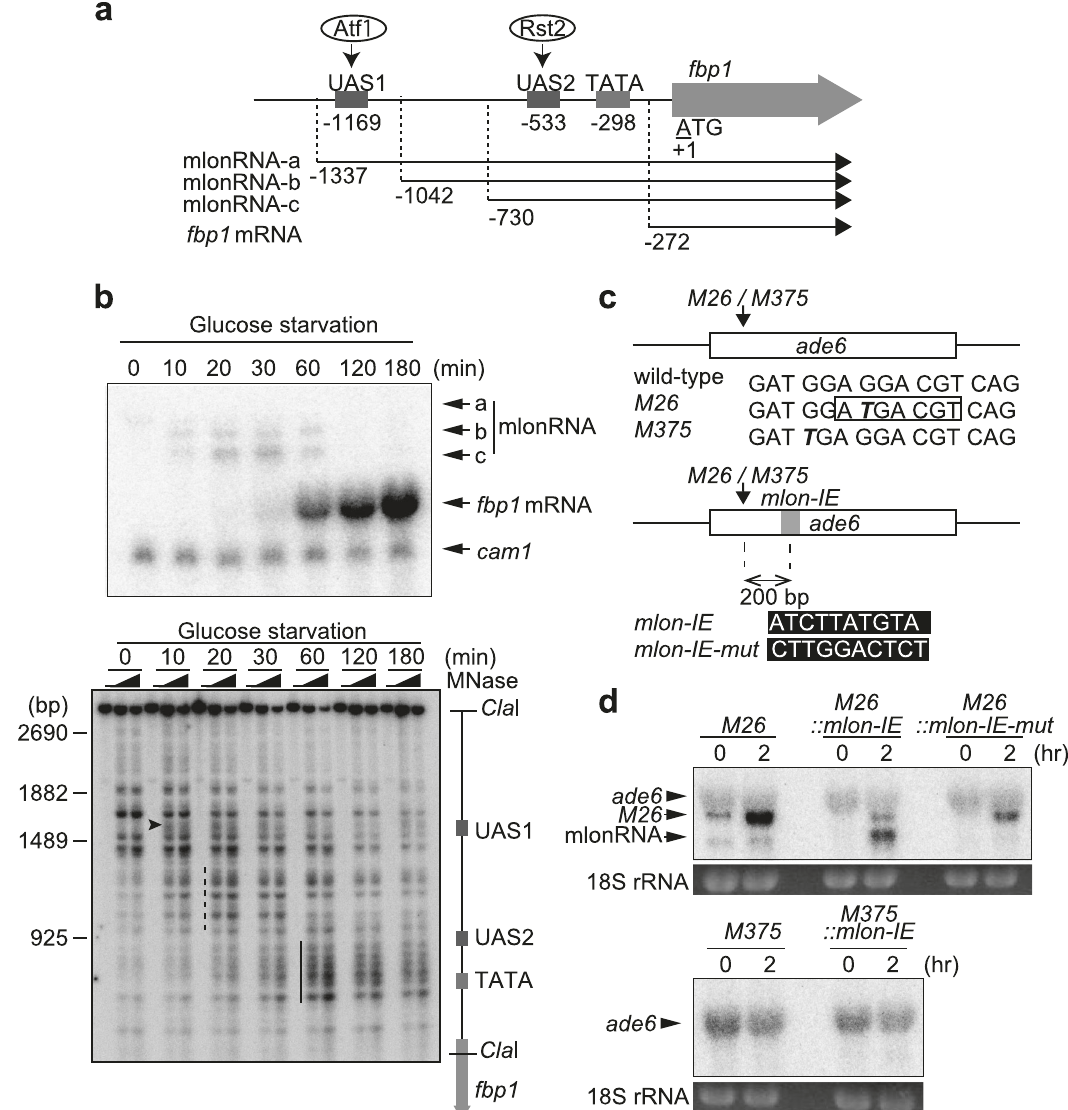
Fig. 1 mlon-IE works at other loci and conditions in addition to its role in the fbp1 upstream region. a Schematic representation of the fbp1 upstream region containing upstream activating sequence 1 and 2 (UAS1 and UAS2), the binding sites for Atf1 and Rst2, respectively. The numbers indicate the transcription start site of the fbp1 transcripts and the distances of UAS1, UAS2 and the TATA box from the fi rst ATG of fbp1 open reading frame (ORF). b Representative images of northern blot showing stepwise expression of mlonRNAs and fbp1 mRNA and blot of the chromatin analysis showing stepwise chromatin remodeling during glucose starvation. Wild-type haploid cells were grown to 2.0 × 10 7 cells/ml in YER medium, then transferred to YED medium. Cells were harvested at the indicated times. cam1 transcript was used as an internal control. c M26 and M375 mutations in ade6 (bold italic) and inserted mlon-IE sequences are shown. d ade6 transcription in indicated cells. Diploid cells were cultured to induce meiosis, as described in the Methods section. 18S rRNA stained by ethidium bromide is shown as the loading (Supplementary Fig. 2a) 32 . M26::mlon-IE cells and parental ade6-